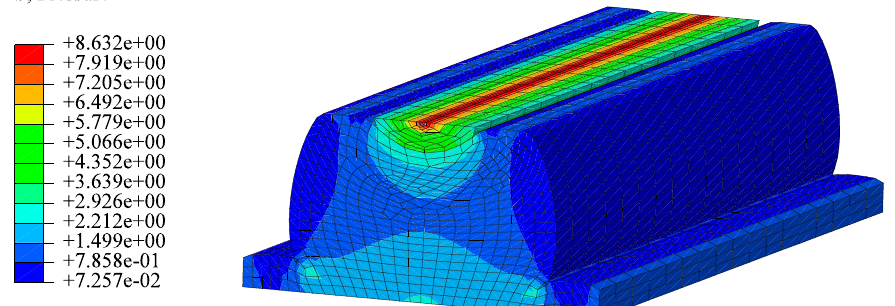
Figure 18. Stresses of GINA gasket under design compression (MPa).